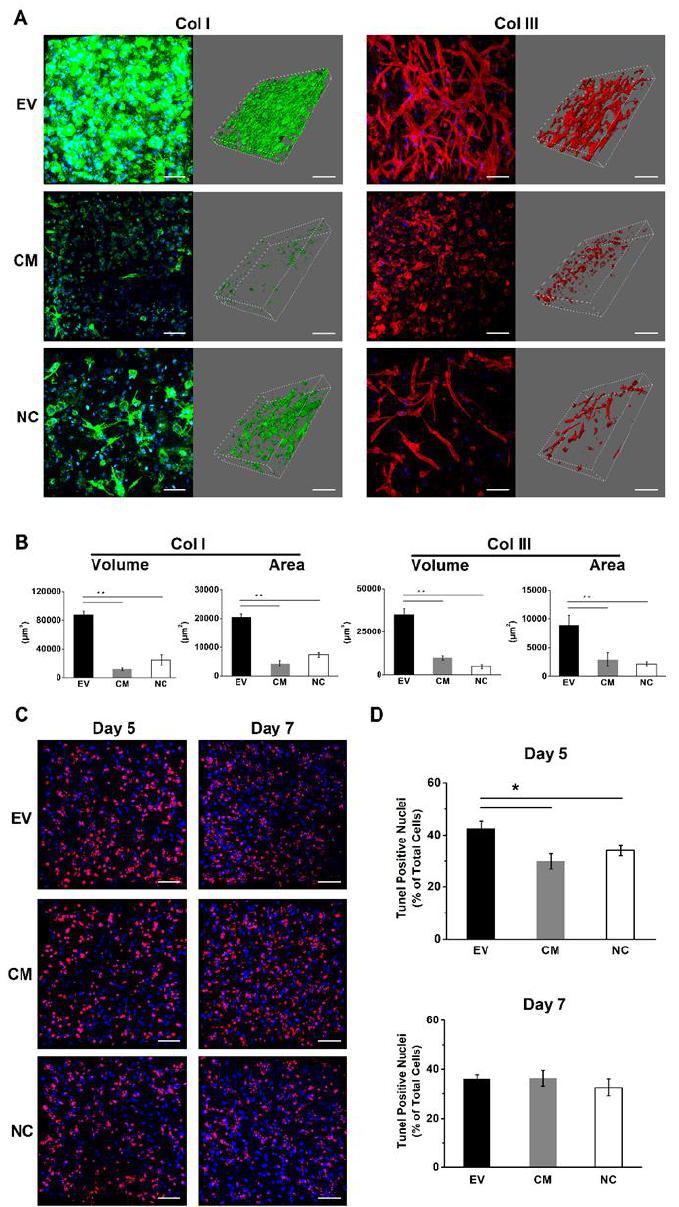
Figure 5. Extracellular matrix and apoptosis assays in 3D in vitro culture. ( A ) Images of collagen deposition in EV-loaded, CM-treated and bare fibrin gels on day 7. (Scale bar: 100 μm) Structure volume and surface area were quantified as parameters and are shown in ( B ). ( C ) Apoptosis was examined in situ using a TUNEL assay. (Scale bar: 100 μm) Quantitative data are shown in ( D ). The mean and standard deviation of triplicate experiments are plotted (* p < 0.05, ** p < 0.01).